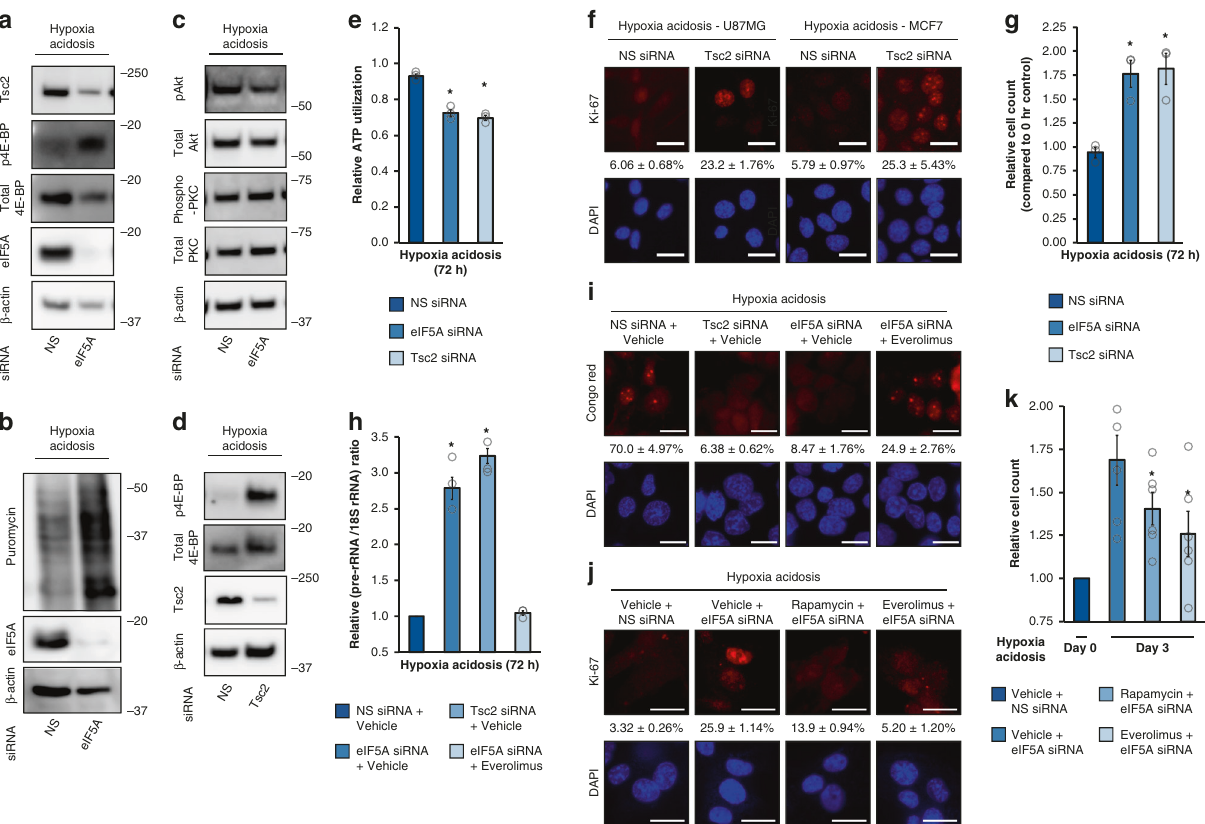
Fig. 4 eIF5A suppresses global metabolism and proliferation through Tsc2/mTORC1. a – c Representative immunoblots of U87MG replete or depleted of eIF5A under hypoxia-acidosis conditions ( n = 3). d Representative immunoblots of U87MG replete or depleted of Tsc2 under hypoxia-acidosis conditions ( n = 3). e Effects of eIF5A and Tsc2 knockdown on cellular ATP levels under hypoxia-acidosis conditions. NS nonsilencing. Data represent mean ± SEM ( n = 3). An asterisk indicates p = 0.024 and 0.012 (eIF5A siRNA and Tsc2 siRNA) compared to NS siRNA, two-sided student ’ s t test. f Representative images of Ki-67 immunocytochemistry in U87MG (left panel) and MCF7 (right panel) replete or depleted of Tsc2 under hypoxia-acidosis conditions. NS nonsilencing. Data represent mean ± SEM ( n = 5). Scale bars: 20 μ m. Effect of Tsc2 knockdown on U87MG g cell number, h transcriptional intensity, and i Congo red staining for A bodies. Scale bars: 20 μ m. NS nonsilencing. Data represent mean ± SEM ( n = 3 ( g , h ); n = 5 ( i )). An asterisk indicates p = 0.046 and 0.042, p = 0.007 and 0.002 ( g , h eIF5A siRNA and Tsc2 siRNA) compared to NS siRNA, two-sided student ’ s t test. j Representative images of Ki-67 immunocytochemistry in U87MG replete or depleted of eIF5A and treated with mTORC1 inhibitors rapamycin and everolimus under hypoxia-acidosis conditions. NS nonsilencing. Data represent mean ± SEM ( n = 5). Scale bars: 20 μ m. k Effect of mTORC1 inhibition on eIF5A-replete or -depleted U87MG cell number under hypoxia-acidosis conditions. NS nonsilencing. Data represent mean ± SEM ( n = 6). An asterisk indicates p = 0.026 and 0.022 (Rapamycin + eIF5A siRNA, Everolimus + eIF5A siRNA) compared to Vehicle + eIF5A siRNA, two-sided student ’ s t